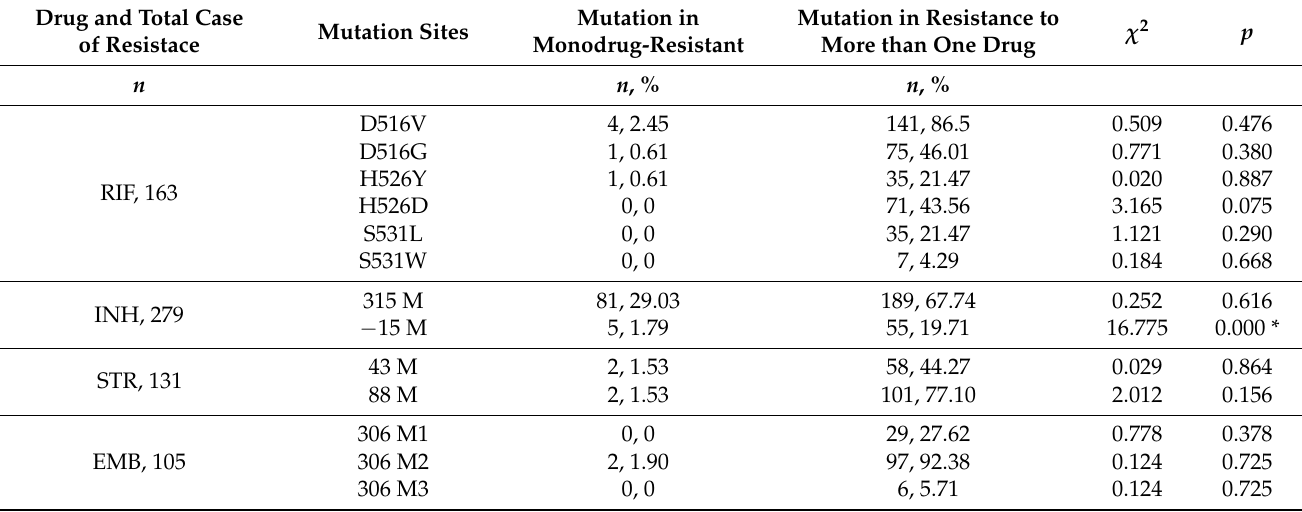
Table 5. Mutation sites in monodrug-resistant and resistance to more than one